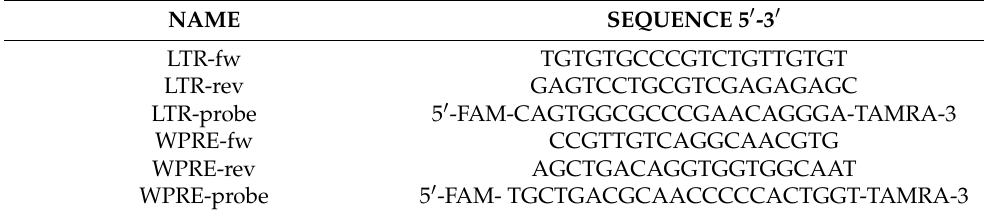
Table 3. Primers for qPCR of LTR and